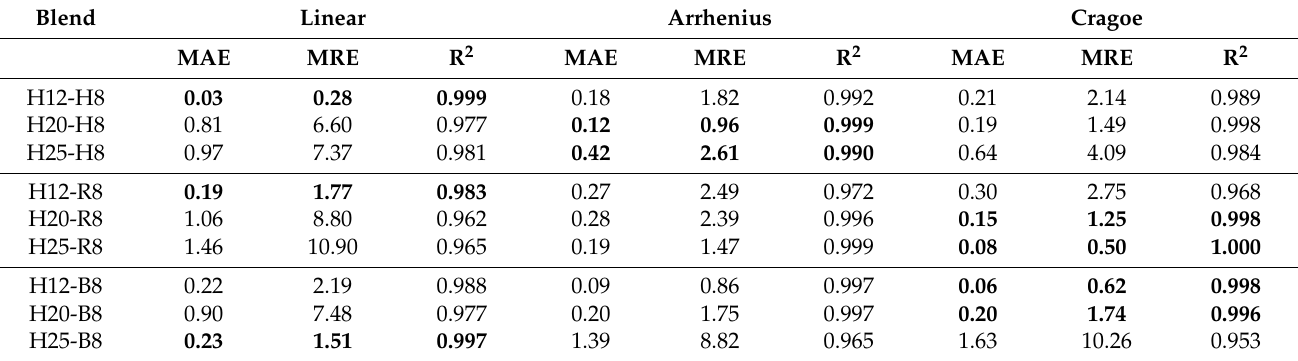
Figure 2. Melt flow rate depending on the weight fraction of H8, R8, and B8 of blends with ( a ) H12, ( b ) H20, and ( c ) H25. Table 8. MAE (in g/10 min), MRE (in %) and R 2 for extrusion material blends. Arrhenius